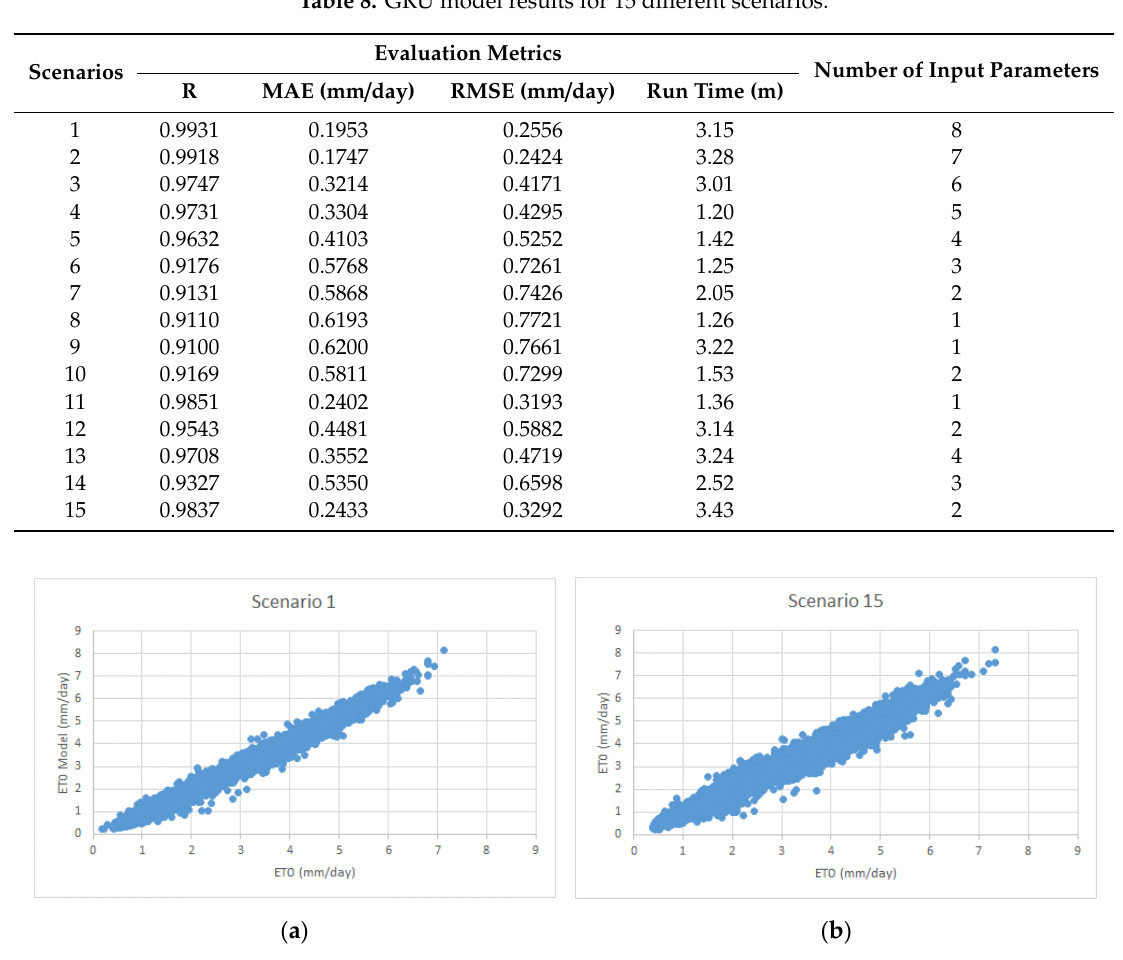
Table 8. GRU model results for 15 di ff erent scenarios.